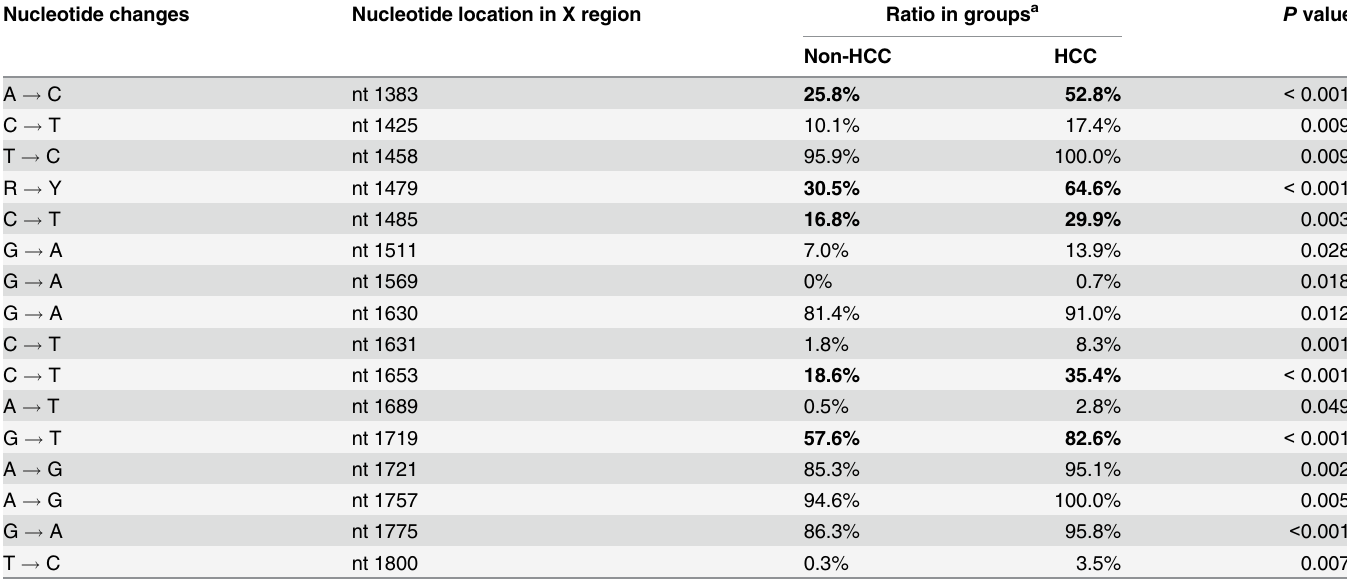
Table 3. Sixteen significant differences of HBx nucleotide sequences between HBV genotype C infected patients with and without HCC. Nucleotide